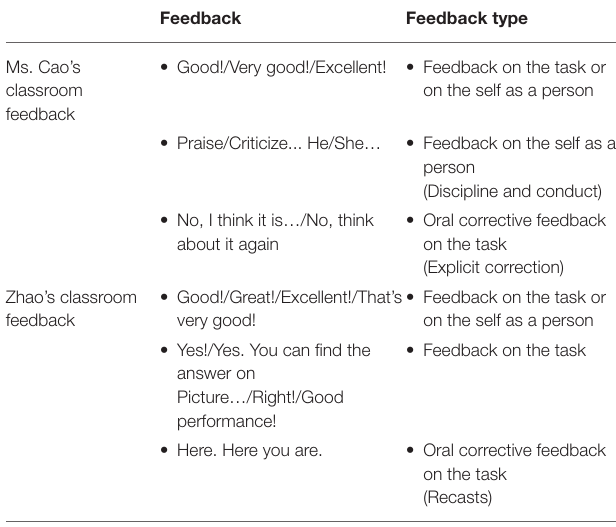
TABLE 3 | Oral feedback patterns of Zhao and his associate teacher Ms.